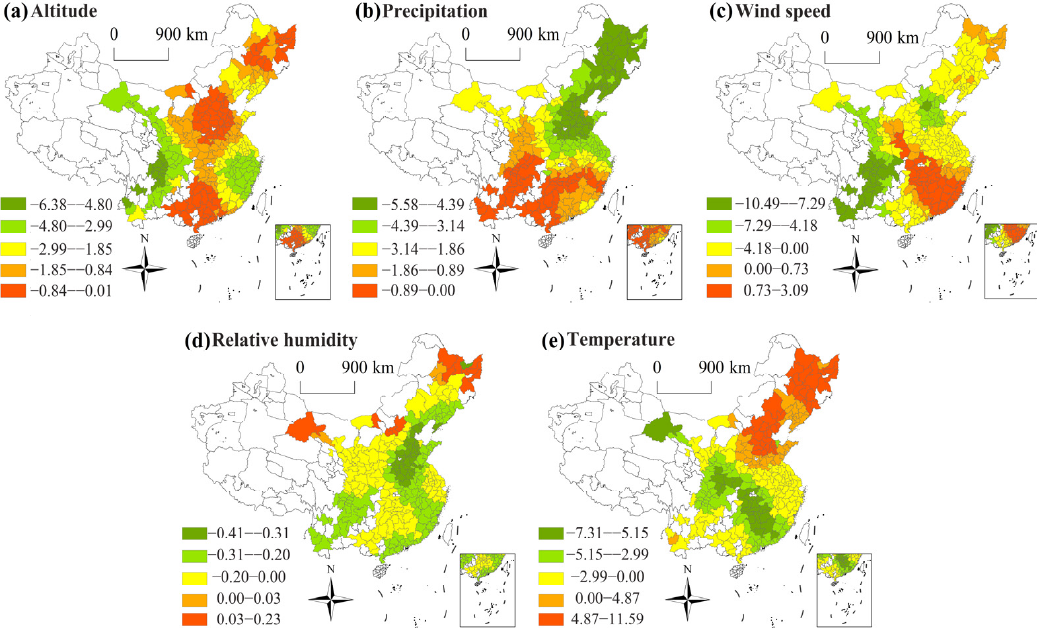
Figure 5. Spatial distribution of natural factors coefficients.